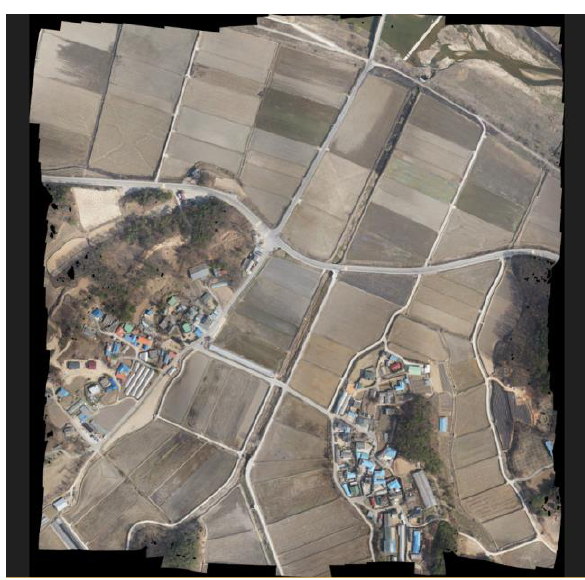
Figure 10. Orthoimage mosaic (flight altitude: 200